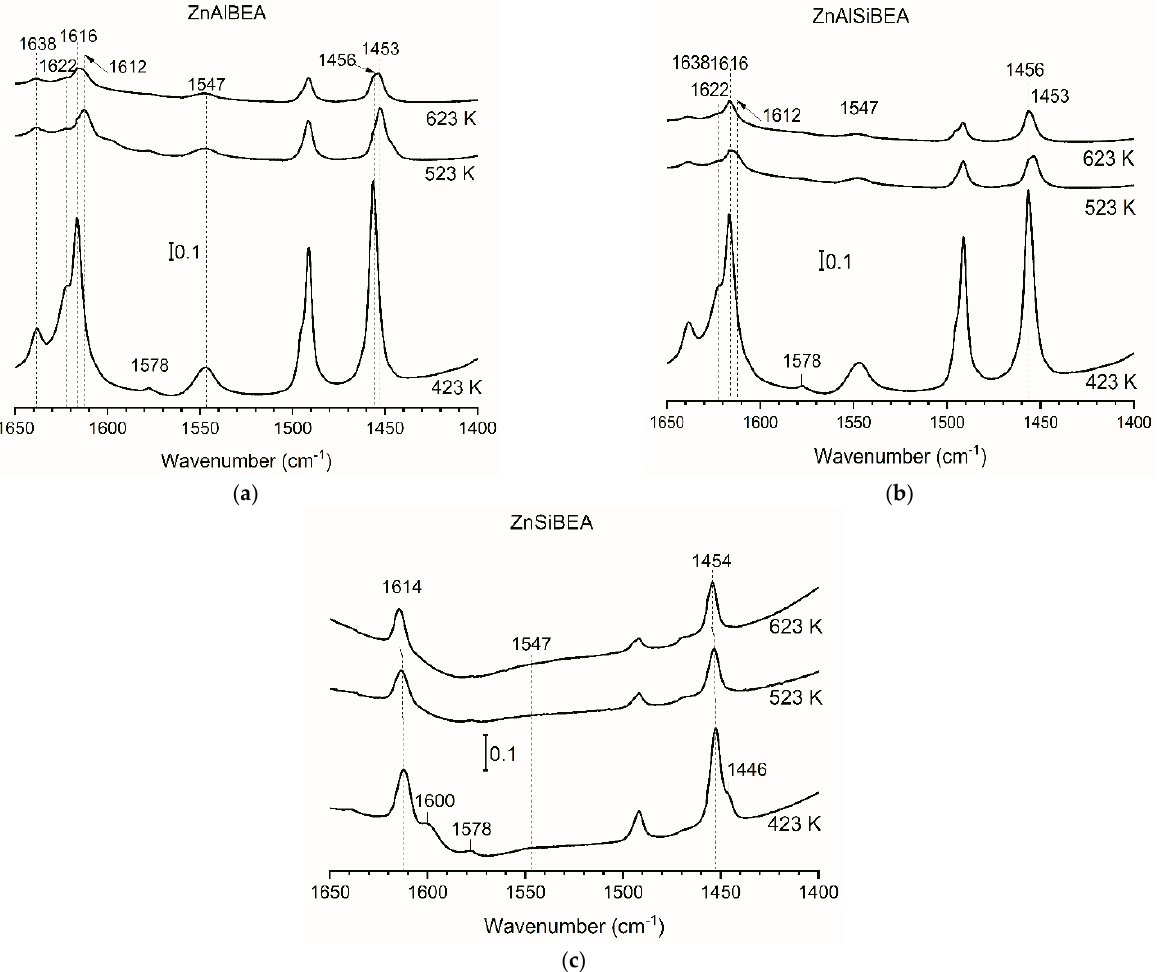
Figure 5. Normalized FTIR absorption spectra of pyridine adsorbed at 423 K on ZnAlBEA ( a ), ZnAlSiBEA ( b ), and ZnSiBEA ( c ) after heat treatment at 873 K and subsequent evacuation at different temperatures.